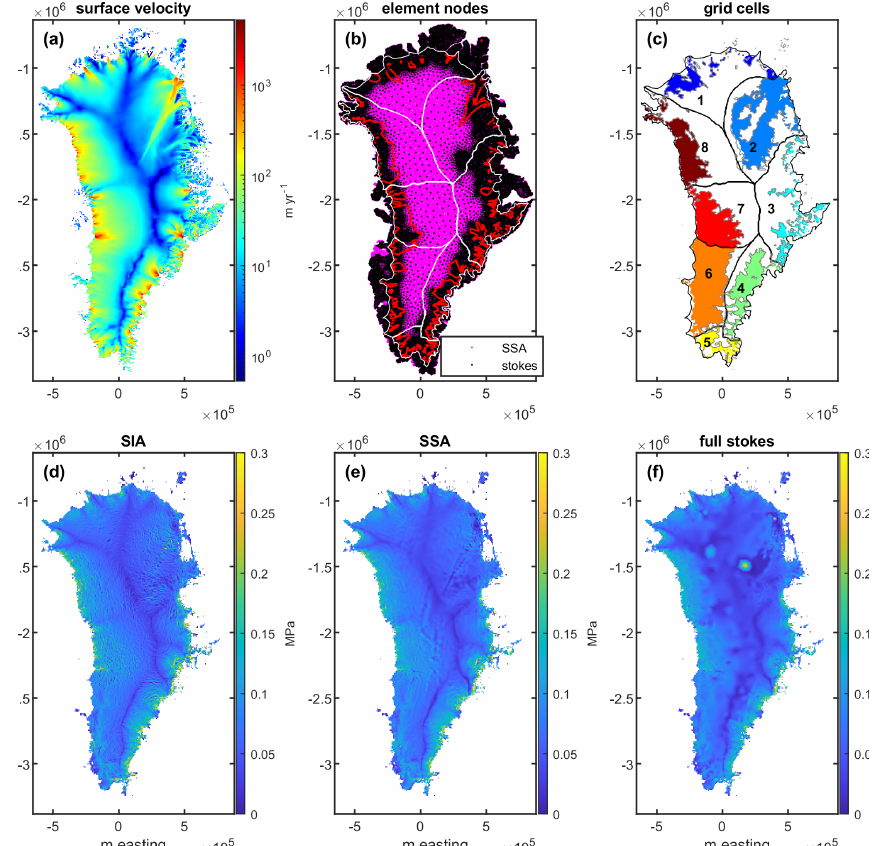
Figure 1. (a) Multi-year surface velocity mosaic for GrIS (Joughin et al., 2018). (b) Element nodes for the SSA (pink dots) and FS (black dots) inversions. The red contour shows the 100myr − 1 velocity contour which delineates the regions from the Stokes inversion used in the analysis. (c) Map of regions used in analysis. Black lines show drainage catchment delineation. The grey line indicates boundary of likely thawed region. (d) Driving stress calculated over 6km × 6km grid cells. (e) Basal traction from SSA inversion averaged over 6km × 6km grid cells. (f) Basal traction from FS inversion averaged over 6km × 6km grid